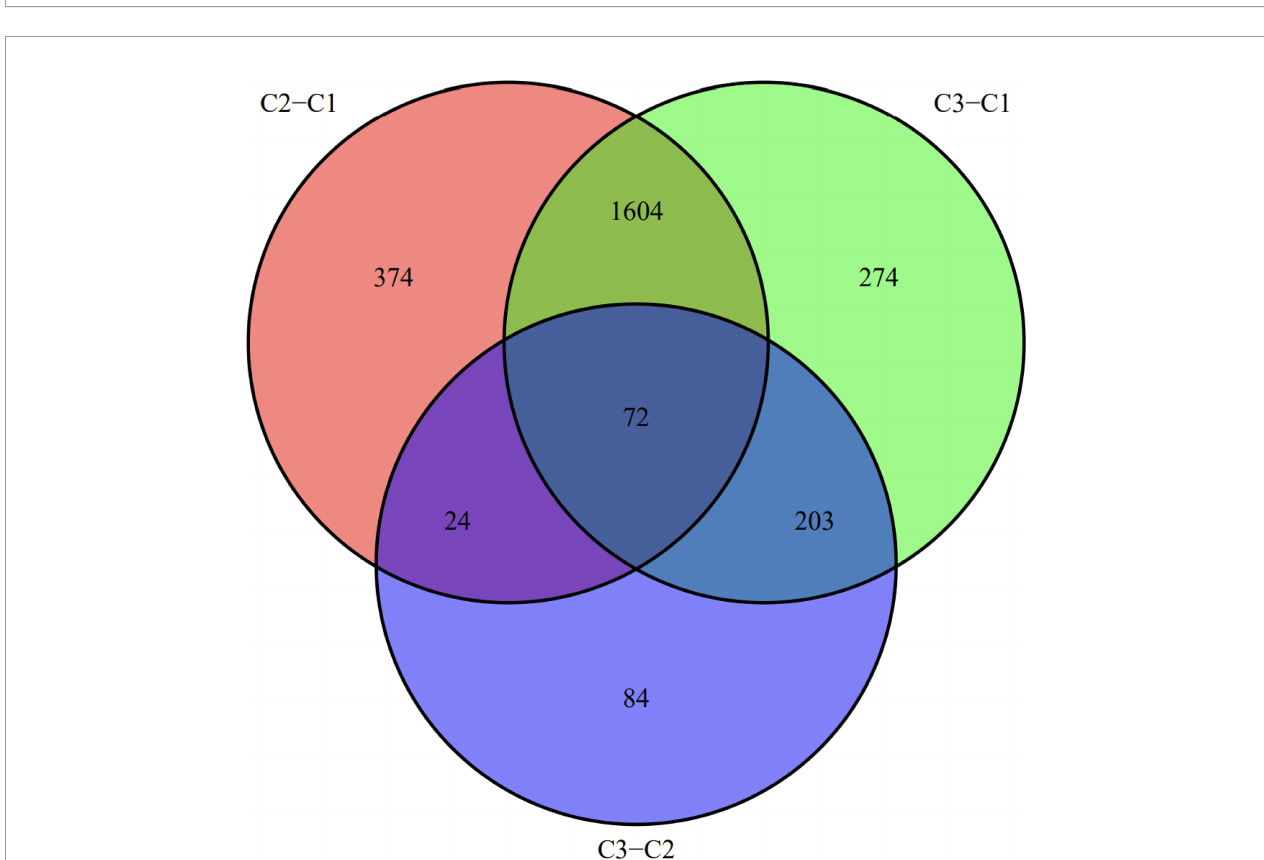
FIGURE 4 | Differential gene sets ’ expression of clinical features and cancer subtypes. * means P<0.05, and *** means P<0.001.